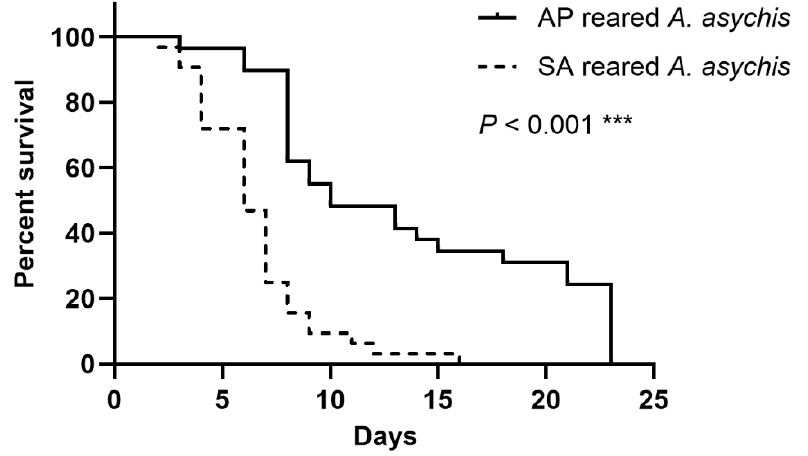
Figure 1. Percent survival of A. asychis emerging from A. pisum (AP-reared A. asychis ) and S. avenae (SA-reared A. asychis ) at 25 °C. *** means p <